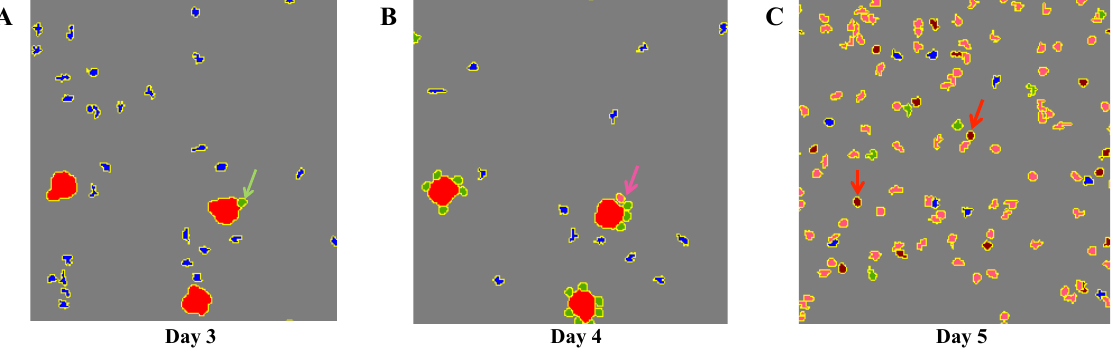
Figure 4. Representative simulation snapshots showing the evolution and differentiation of T-cells following the APC encounter. ( A ) The green arrow shows a naïve T-cell (blue) which turned into a preactivated cell (green) once it came into contact with an APC cell (red); ( B ) The magenta arrow shows an activated T-cell; and ( C ) the red arrows show effector T-cells (dark brown). All APCs have died by Day 5. The parameters used for simulations are presented in Tables 3–5, with periodic boundary conditions. See also the Supplementary Movie for the full temporal events (representing 2.5 days of real time; from Day 3 to Day 5.5 post infection). Note that Day 3 is the initial time point in our